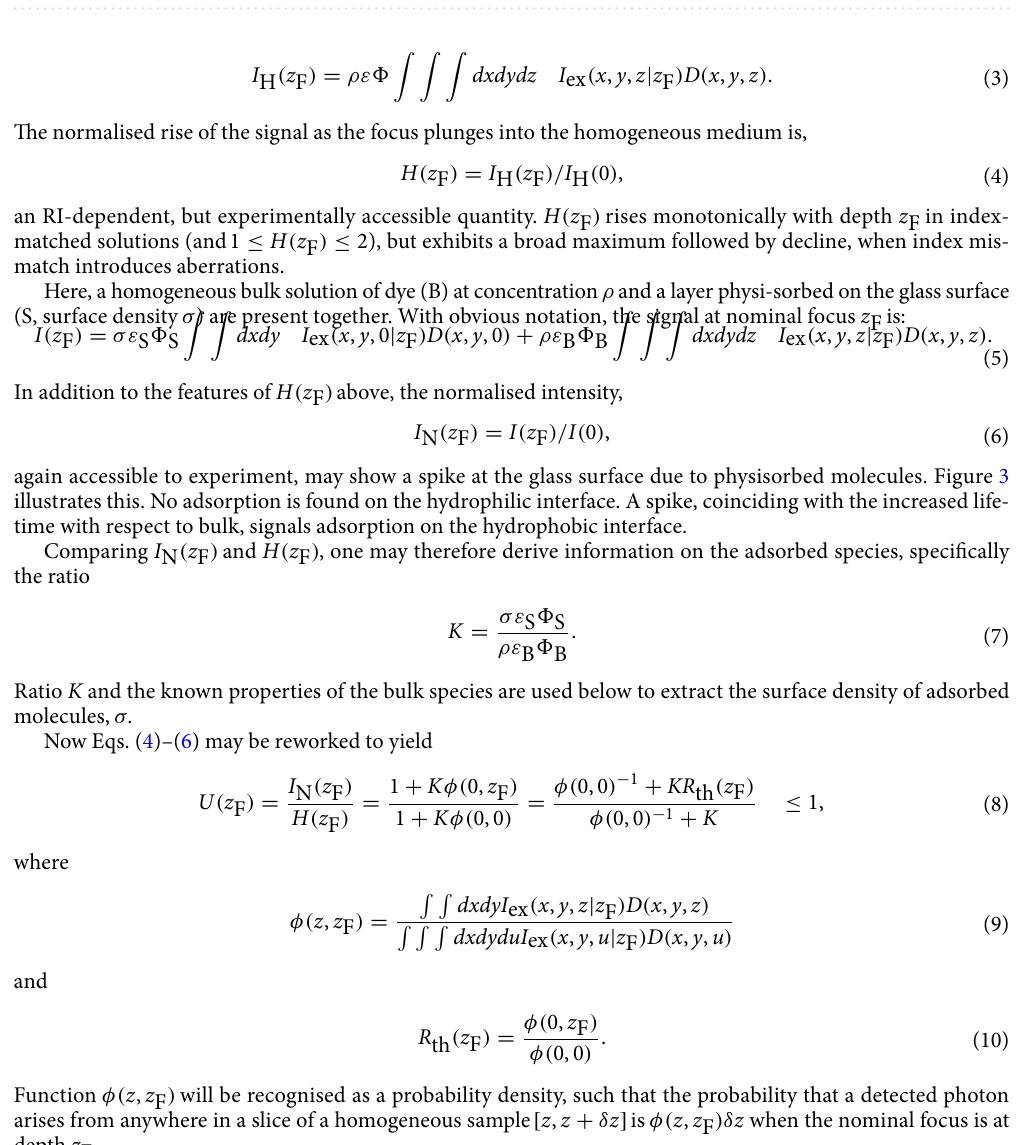
Figure 3. Sample data Relative intensity during a z -scan into a 70 wt.% glycerol solution of 4-daspi (white area), from the hydrophobic glass (blue, showing a spike due to the adsorbed dye) or the hydrophilic glass (yellow, no adsorption